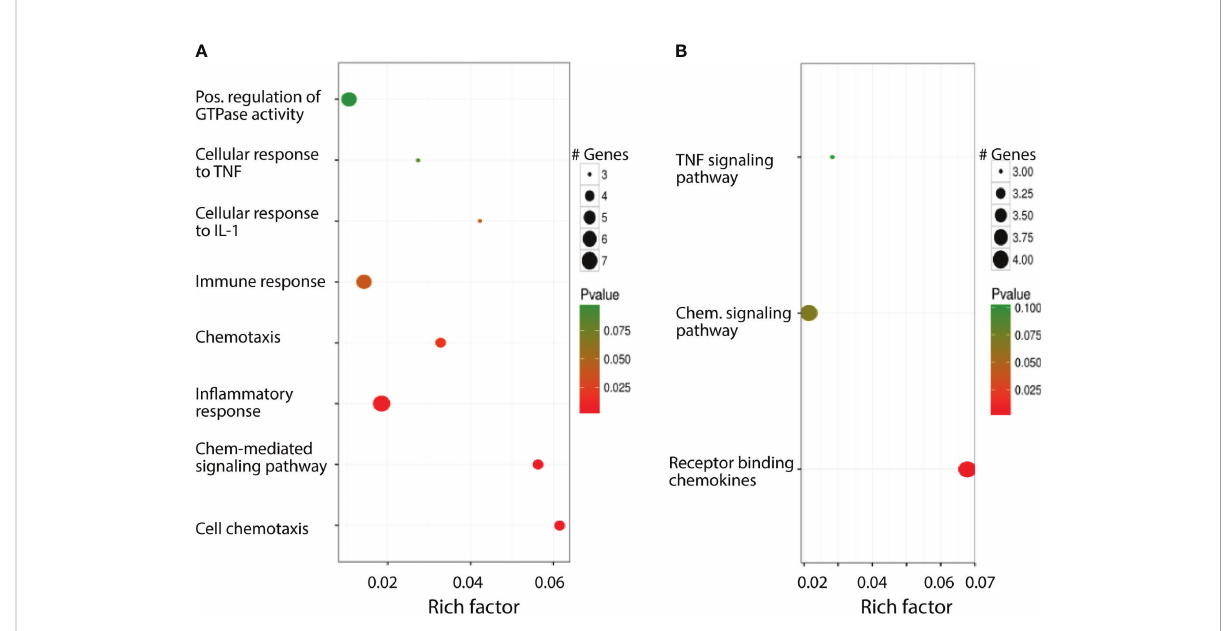
FIGURE 2 Biological processes the differentially expressed genes involved in. (A) Signi fi cantly enriched GO BP terms. (B) Signi fi cantly enriched